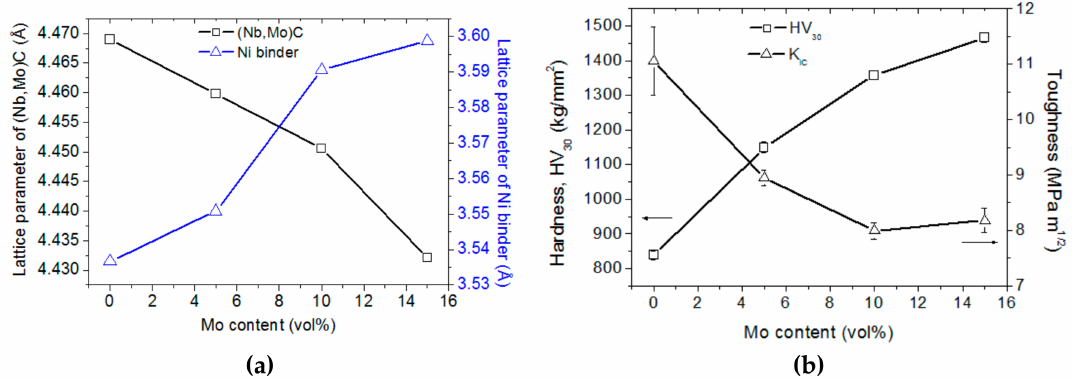
Figure 9. Influence of Mo addition on the lattice parameters of the carbide (square symbol) and binder phases (triangle symbol) ( a ) and mechanical properties ( b ) of (NbC- x vol % Mo)-12 vol % Ni